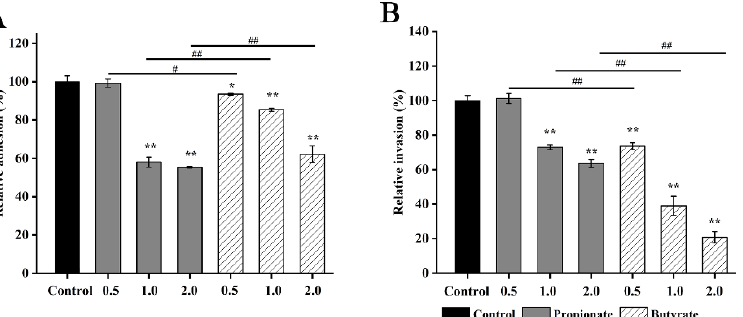
Figure 7. Effect of SCFAs on the ( A ) adhesion to and ( B ) invasion of S. Typhimurium SL1344 to Caco-2 cells. “*” and “**” indicates significance compared to the control. “ # ” and “ ## ” indicates significance between different SCFAs treatments. “*” “ # ” p < 0.05, “**” “ ## ” p < 0.01.